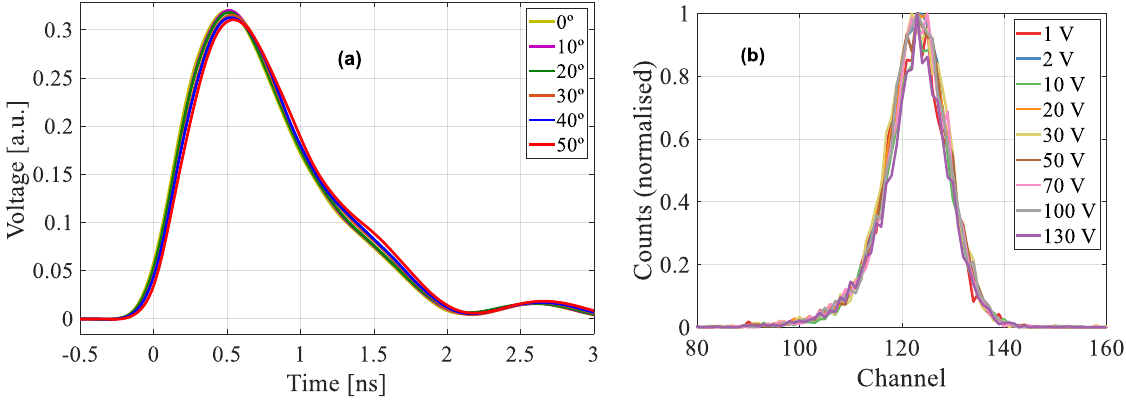
Figure 10. PIN measurements. ( a ) TRIBIC waveforms normalised to total deposited charge from 0° to 50°. ( b ) IBIC spectra in the bias voltage range 10 – 130 V.